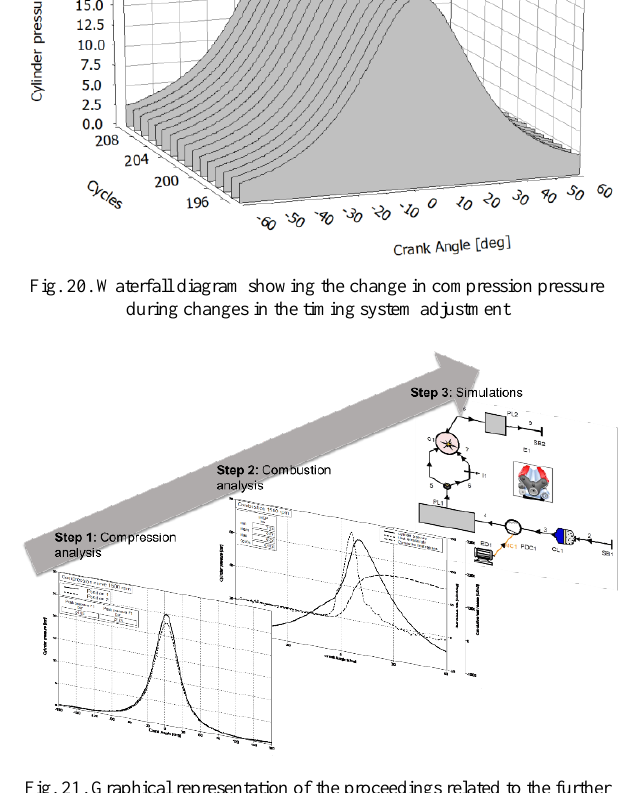
Fig. 21. Graphical representation of the proceedings related to the further development of the test